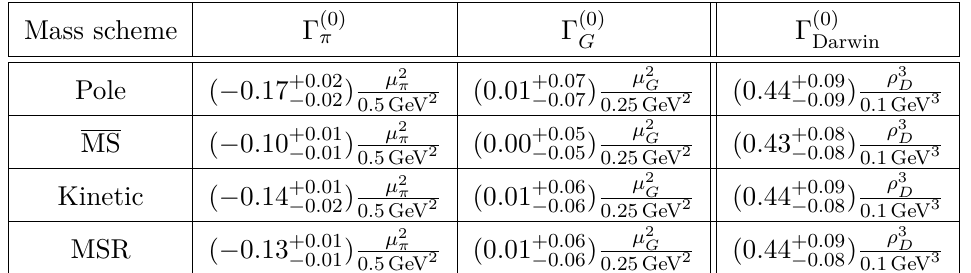
Table 9. LO values of dimension-five and dimension-six non-spectator contributions to the total decay widths, Γ and Γ , respectively, for several schemes of the charm-quark mass. The π,G Darwin numerical coefficients are in units ps − 1 , and the non-perturbative parameters µ 2 GeV 2 , GeV 2 and GeV 3 , respectively. See the caption of table 8, and table 5, for further details about the input parameters. The expressions are valid for both mesons and baryons, after the suitable replacements of the hadronic